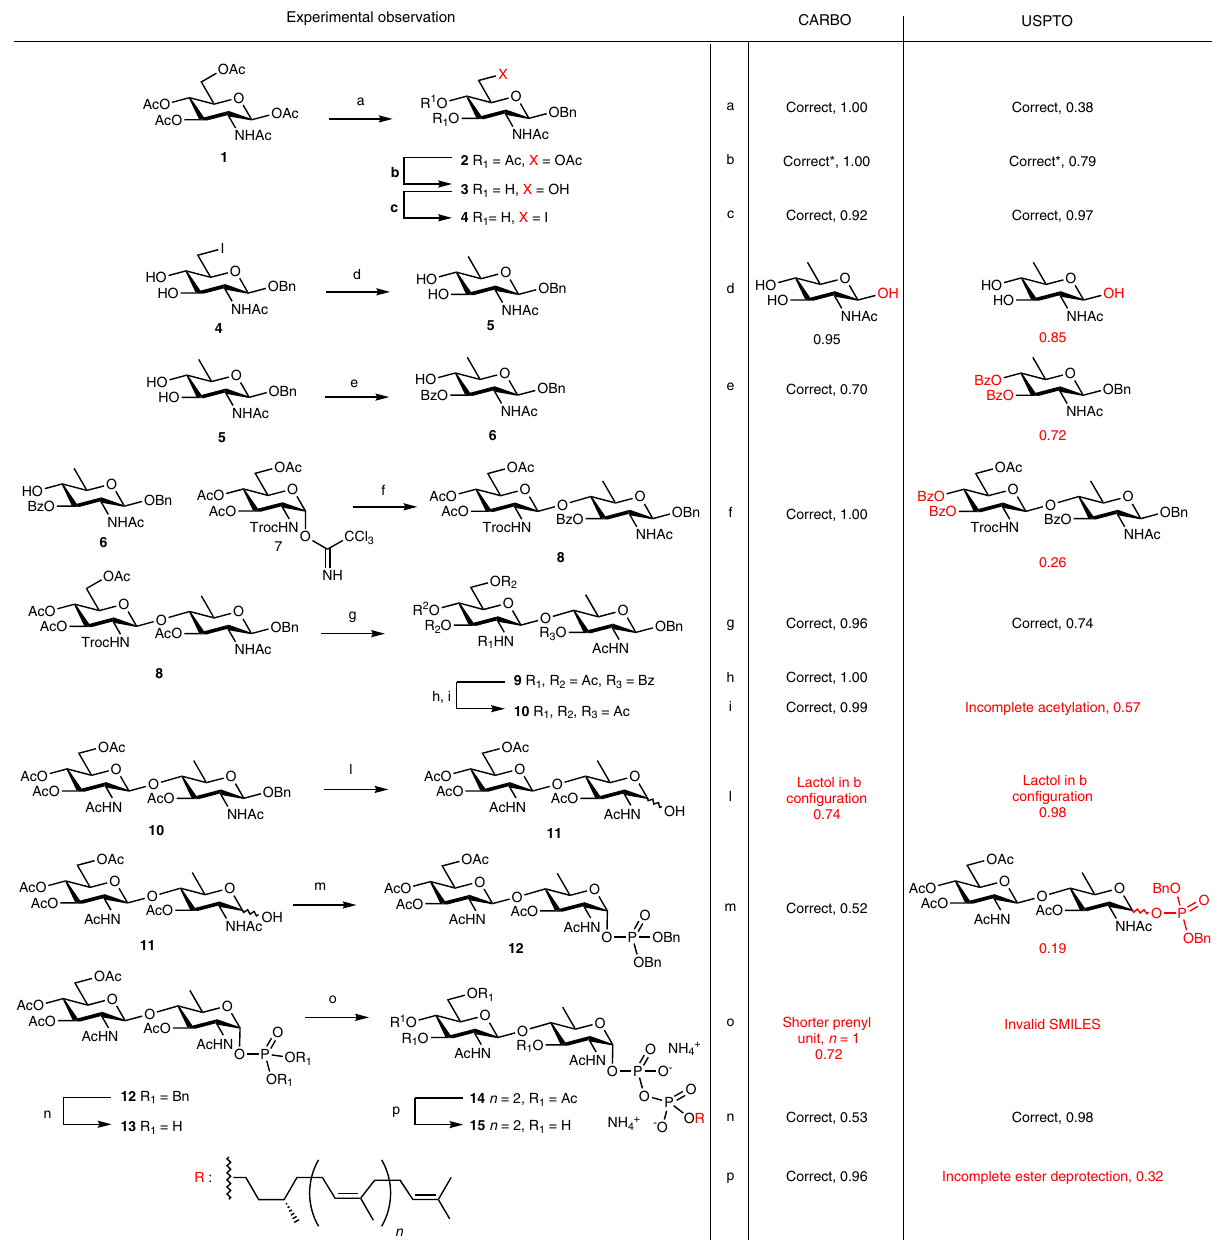
Fig. 4 Synthesis of lipid-linked oligosaccharide (LLO). Reaction conditions: a BnOH, Yb(OTf) 3 , DCE, 90 °C, 2h, 78%. b MeONa, MeOH, sonication, 30 min. c PPh 3 , I 2 , imidazole, THF, 1h, re fl ux, 88% over two steps. d Pd/C, NH 4 OH, H 2 , THF/H 2 O, 30 min, 77%. e BzCl, pyr, − 35°, 70%. f BF 3 Et 2 O, 4 MS, DCM, 26 h, 73%. g Zn, Ac 2 O, AcOH, DCE 50°, 3 h, 96%. h MeONa, MeOH/DMF, 4 days. i Ac 2 O, 4-(Dimethylamino)pyridine, pyr, 76% over three steps. l H 2 , THF/H 2 O, 10 bar, 16 h. m LiHMDS, tetrabenzylpyrophosphate, 53%. n H 2 , THF/MeOH, 1 h. o farnesylnerol, CDI, DMF, then 11 , 5 days, 18%. p MeOH, NH 4 OH, 16 h, qte. An asterisk represents “ * ” reaction present in the training